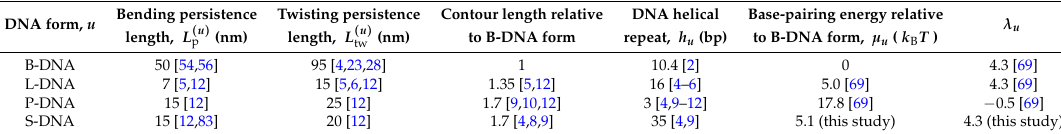
Table 1. Structural and elastic characteristics of various DNA forms. DNA form, u Bending persistence Twisting persistence Contour length relative